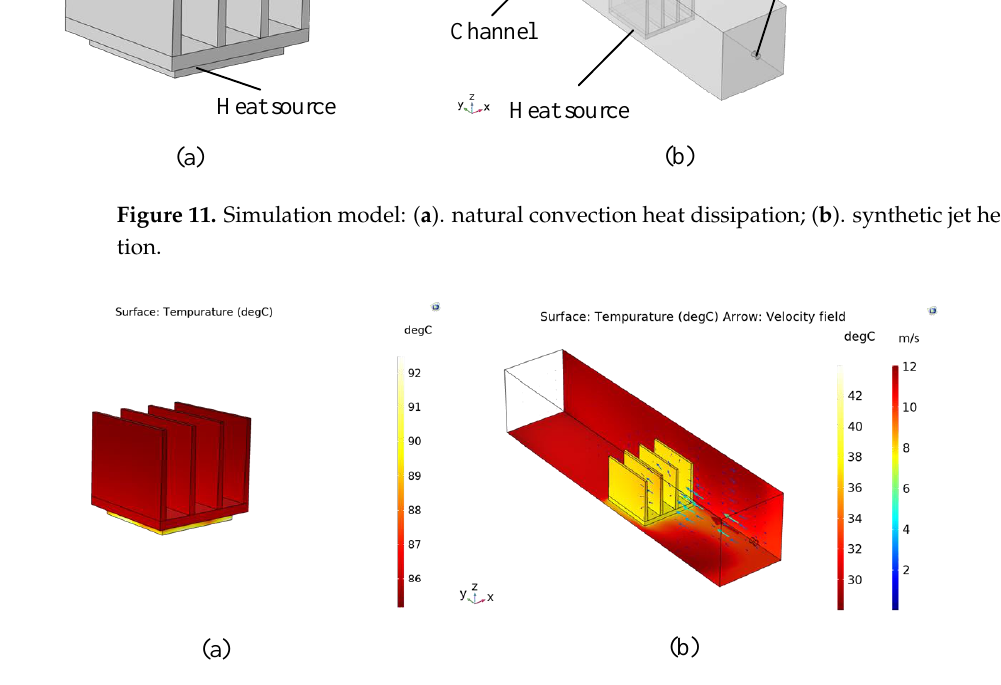
Figure 12. Temperature nephogram: ( a ). natural convection heat dissipation; ( b ). synthetic jet heat dissipation.